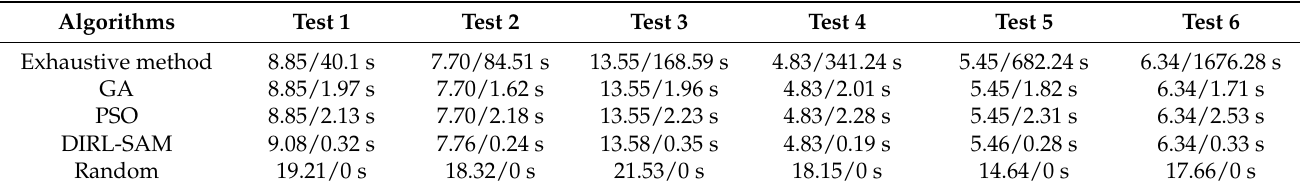
Table 8. Compared results of different methods.